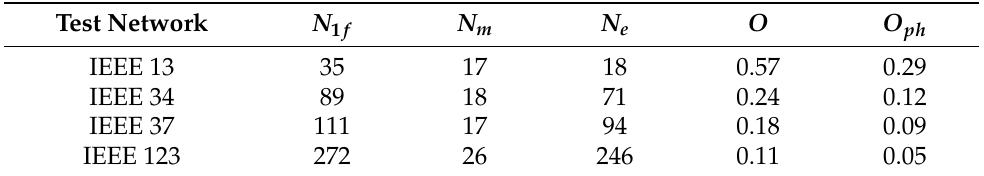
Table 3. Number of measured ( N m ) and estimated ( N e ) one-phase voltages and observability factors for tested networks.